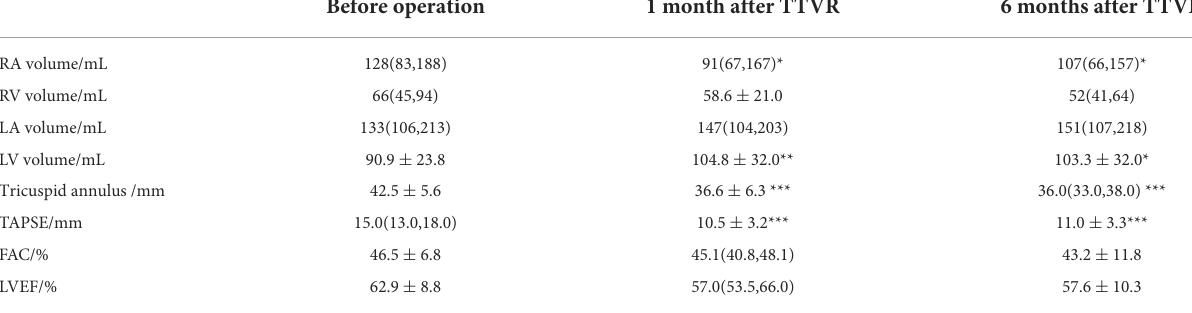
TABLE 6 Echocardiography